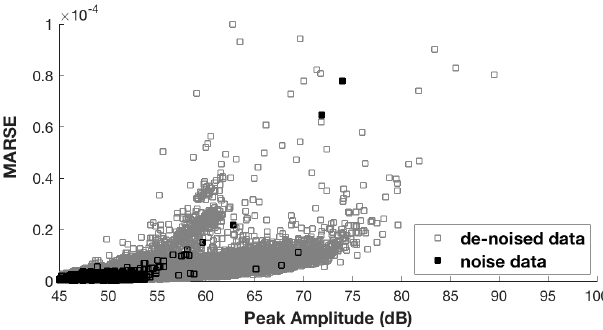
Figure 2. Peak amplitude vs. MARSEdistribution for noise signals and de-noised signals, respectively.